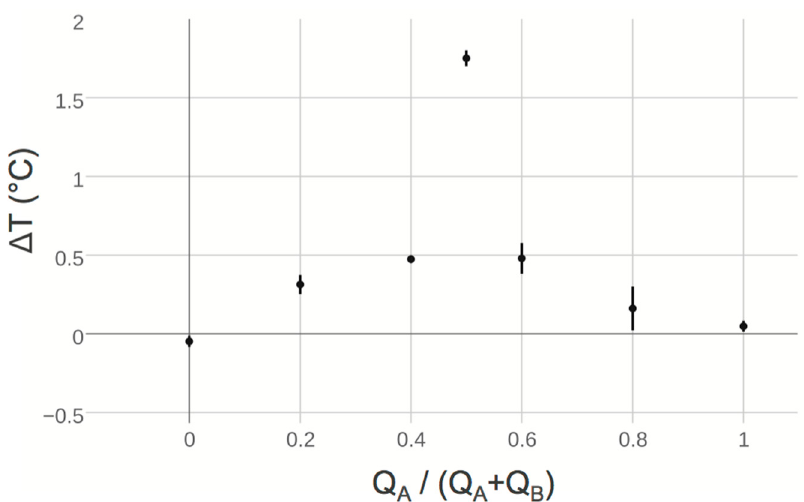
Figure 4. Two solutions, an acid and base, with approximately equal normality were combined in the microfluidic circuit shown in Figure 2 to perform a continuous-flow titration. Their volumetric mixing ratio Q A /( Q A + Q B ) was varied by parametrically by increasing the flow rate of acid solution while decreasing the flow rate of base solution such that the total flow rate Q = Q A + Q B in the sensor was always 5 mL/h. The change in temperature before and after mixing ∆ T was measured in a similar manner used to characterize device flow rate dependent response, predictably locating the equivalence point at a volumetric mixing ratio 0.5. The resulting data were shifted by the average value due only to device behavior, or when only acid or base solution was present. Error bars shown represent the standard deviation of data collected during the recording period.